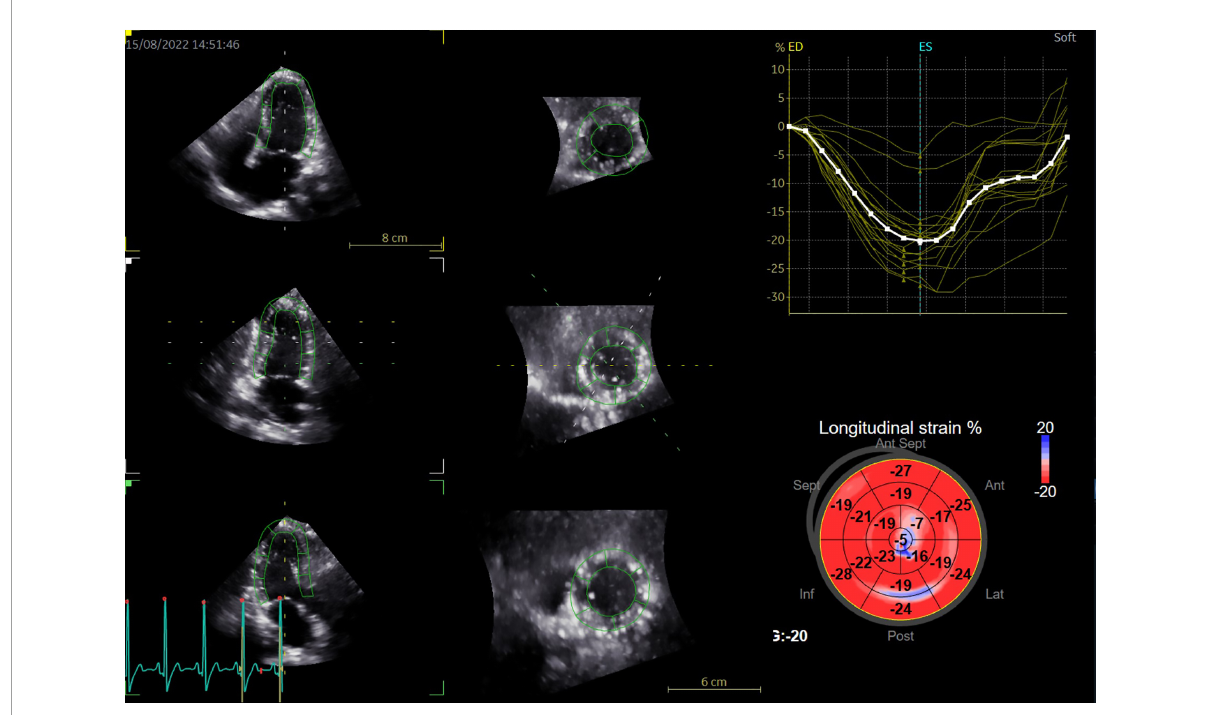
FIGURE1 Representative diagram of three-dimensional speckle-tracking strain measurements in a patient with breast cancer treated with chemotherapy (left panel: sections generated by 3D full-volume image cut of the LV, right panel: the color-coded bull’s eye plot of the longitudinal strain in the LV 17 segment and corresponding longitudinal strain regional